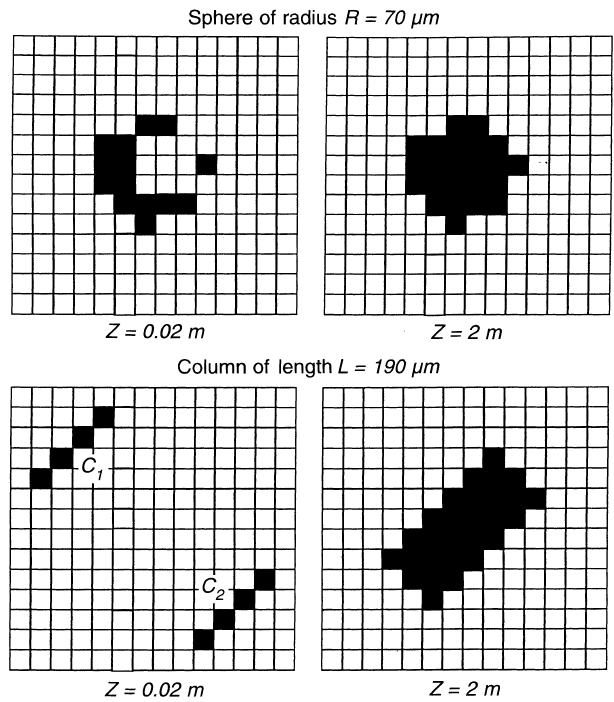
Fig. 2. Examples of di(cid:128)racted images for spheres (of radius R = 70 (cid:108) m) and hexagonal columns (of length L = 190 (cid:108) m) while increasing the distance Z between the particle and the screen from 0.02 to